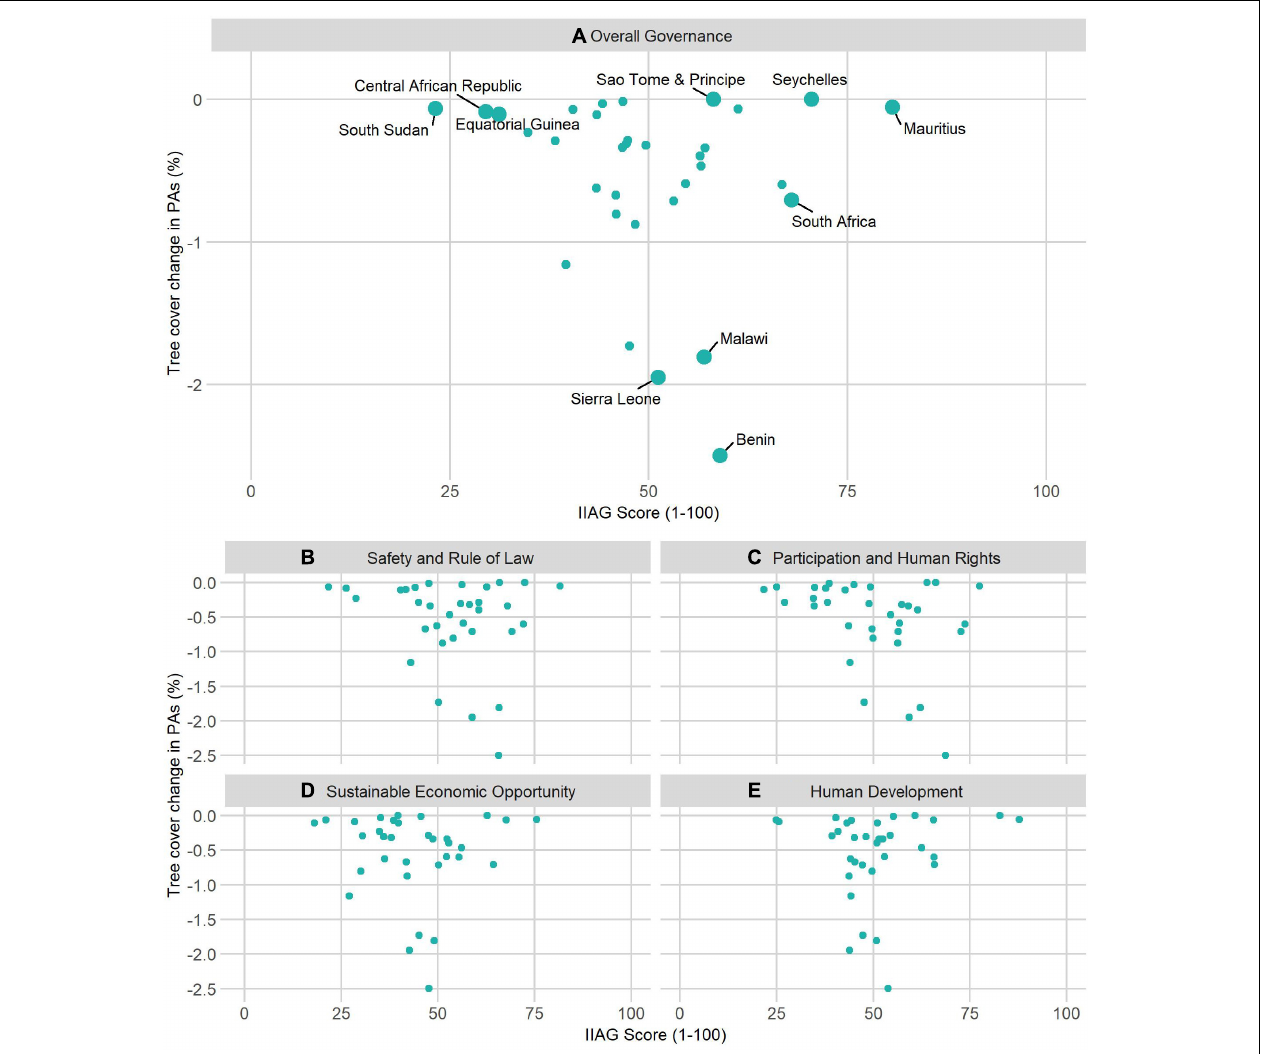
FIGURE 2 | Mean annual rates of tree cover change in PAs plotted against the mean IIAG governance scores for (A) Overall Governance, (B) Safety and Rule of Law, (C) Participation and Human Rights, (D) Sustainable Economic Opportunity, and (E) Human Development for the period 2008-2017. Each point represents one country and countries mentioned in the text are highlighted and